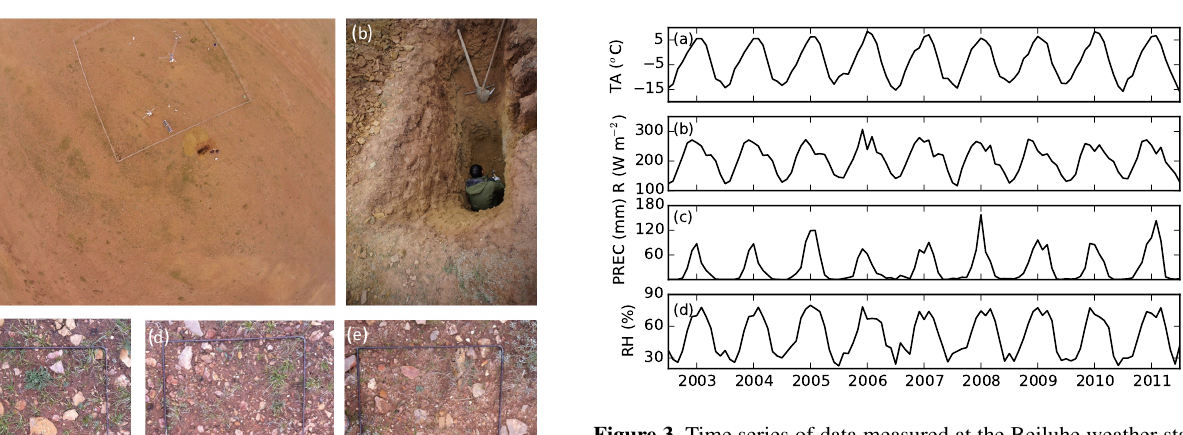
Figure 3. Time series of data measured at the Beiluhe weather sta- tion, Qinghai–Tibetan Plateau, 2003 to 2011: (a) air temperature (TA, ◦ C), (b) downward solar radiation ( R , Wm − 2 ) , (c) precipita- tion (PREC, mm), and (d) relative humidity (RH,